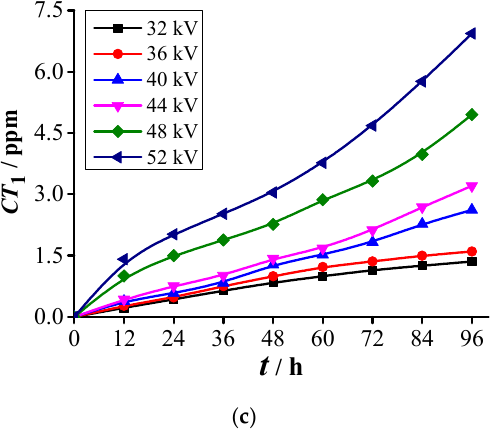
Figure 8. Change of carbon-containing components with time: ( a ) CF 4 ; ( b ) CO 2 ; and ( c ) CT 1 .